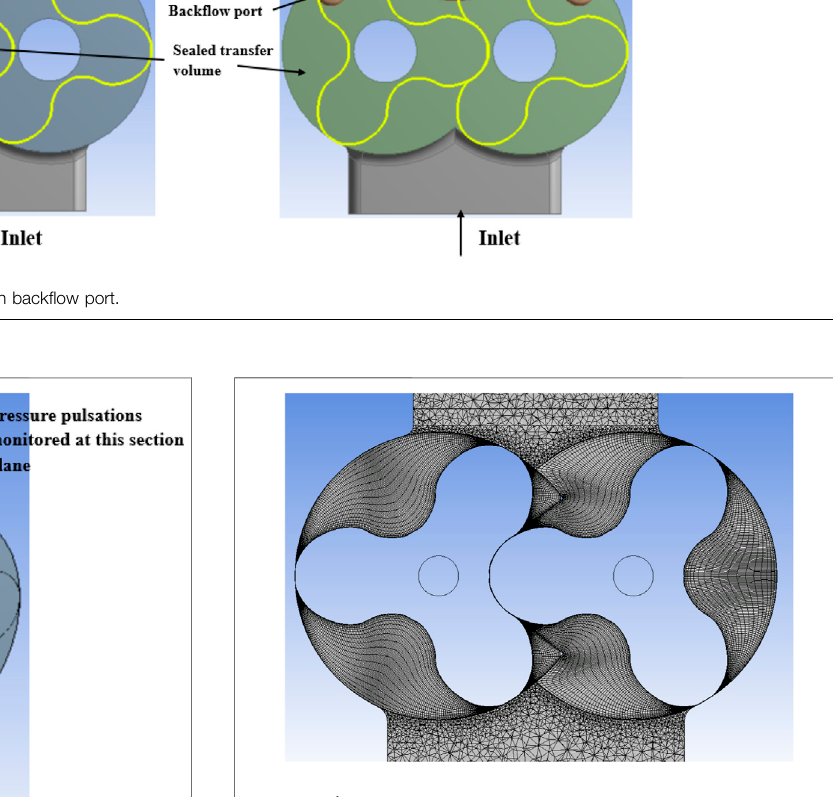
FIGURE 5 | Section plane across the center of the rotors showing hexahedral mesh in the pump deforming zone and tetrahedral mesh in the static